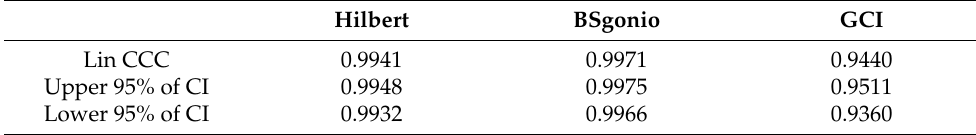
Table 3. Algorithms respective Lin’s concordance correlation coefficients and confidence